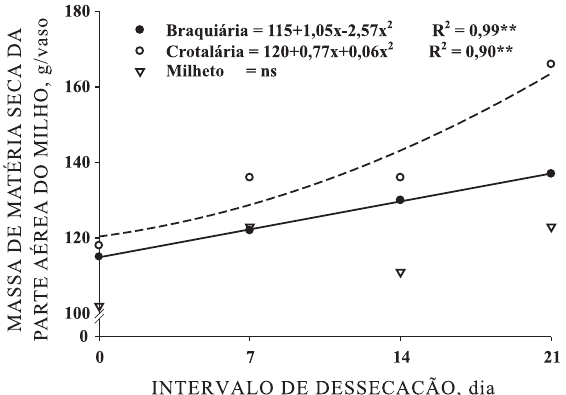
Figura 7. Massa de matéria seca da parte aérea do milho, em função do intervalo de dessecação, em diferentes espécies de plantas de cobertura.